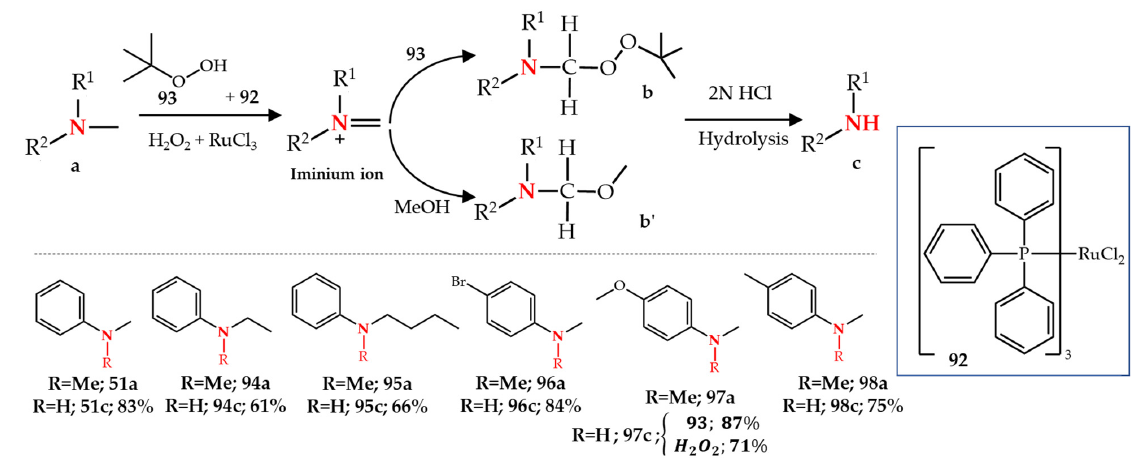
Figure 14. Ru ‐ catalyzed N ‐ dealkylation of amines. Figure 14. Ru-catalyzed N -dealkylation of